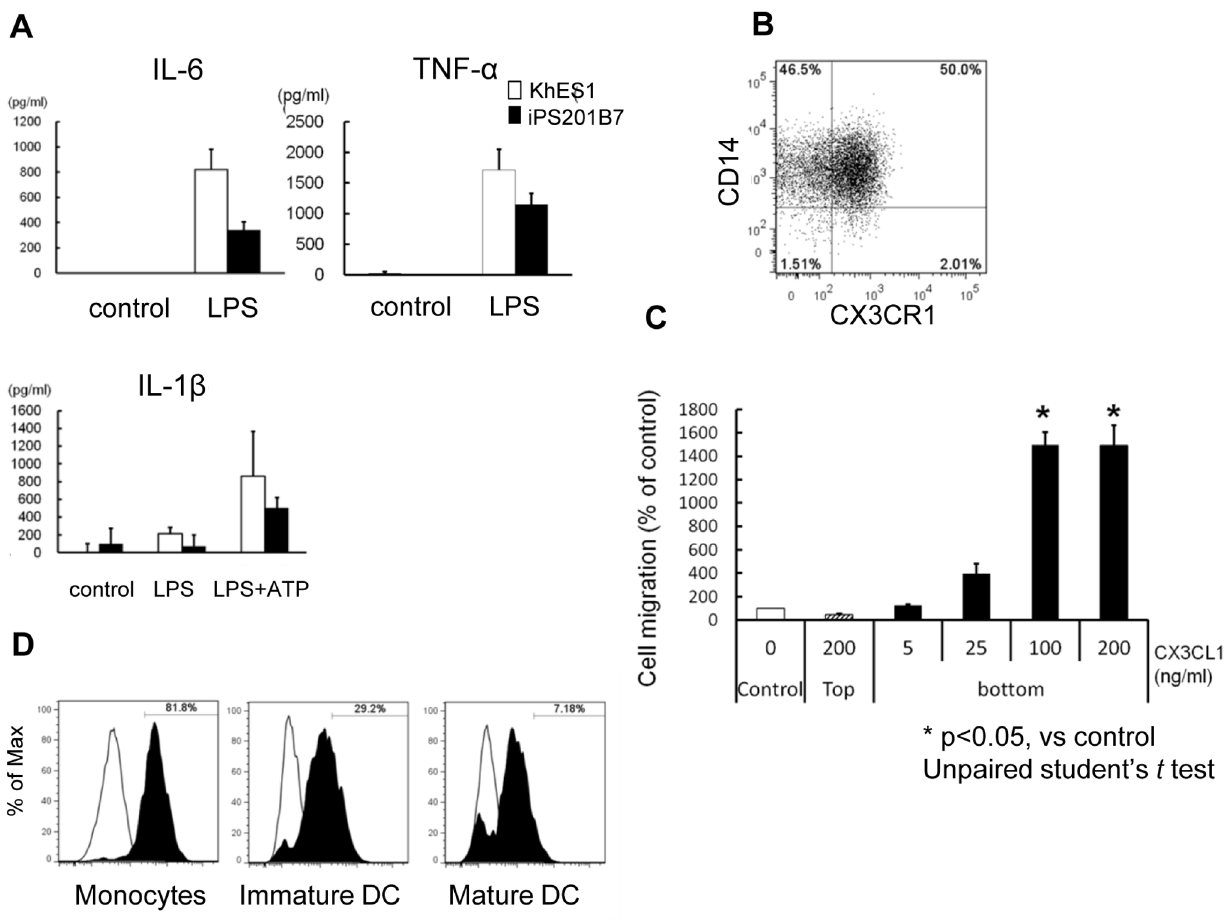
Figure 3. Functional assays for monocytes derived from pluripotent stem cells. (A) The levels of IL-6 and TNF a in supernatants of PS-Mo culture medium 4 hours after LPS stimulation. The levels of IL-1 b were measured 4 hours after LPS stimulation with/without an additional 30-minute ATP stimulation. (B) Flow cytometric analysis of CX3CR1 on PS-Mo. (C) Chemotaxis assay of PS-Mo for CX3CL1 (fractalkine) using a trans-well migration assay. After the addition of CX3CL1 into either the bottom or top of the trans-well chamber, PS-Mo were applied and incubated for 5 hours at 37 u C. (D) Antigen uptake was evaluated in monocytes, immature DCs and mature DCs derived from pluripotent stem cells by examining the fluorescence intensity of Alexa fluor 488-conjugated ovalbumin 45 minute after incubation at 37 u C (black). Control samples (white) were kept on ice. (B–D) The data of KhES1-derived cells are shown as representative. PS-Mo: monocyte derived from pluripotent stem cells.